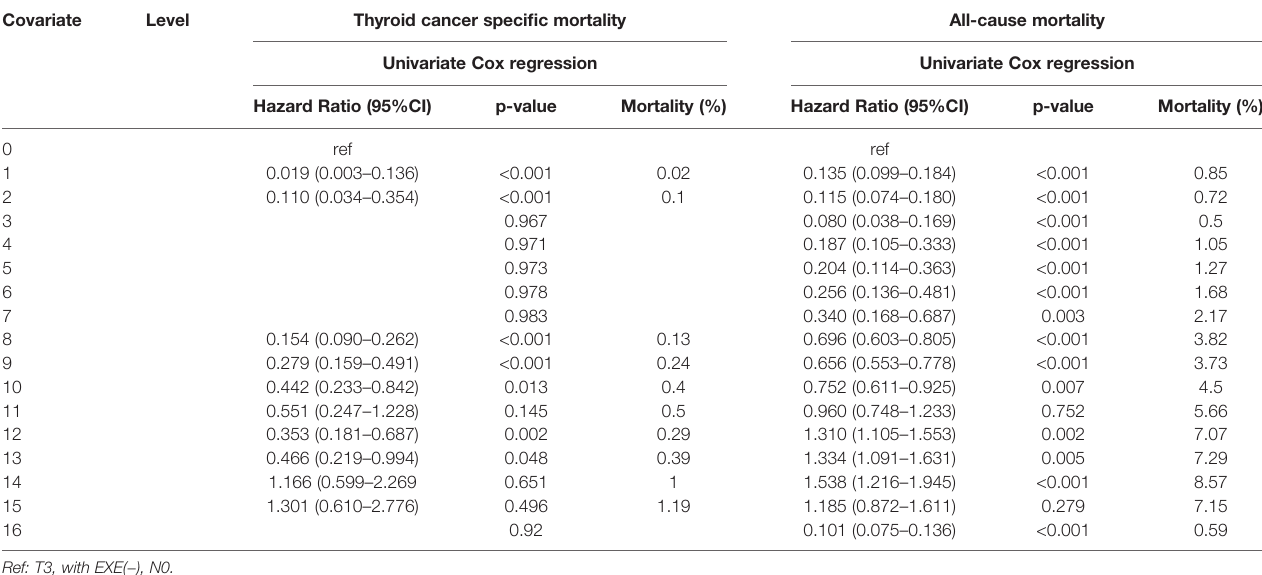
TABLE 5 | Age, T3 and sex, tumor size factors for survival: outcome of thyroid cancer speci fi c mortality and all-cause mortality. Covariate